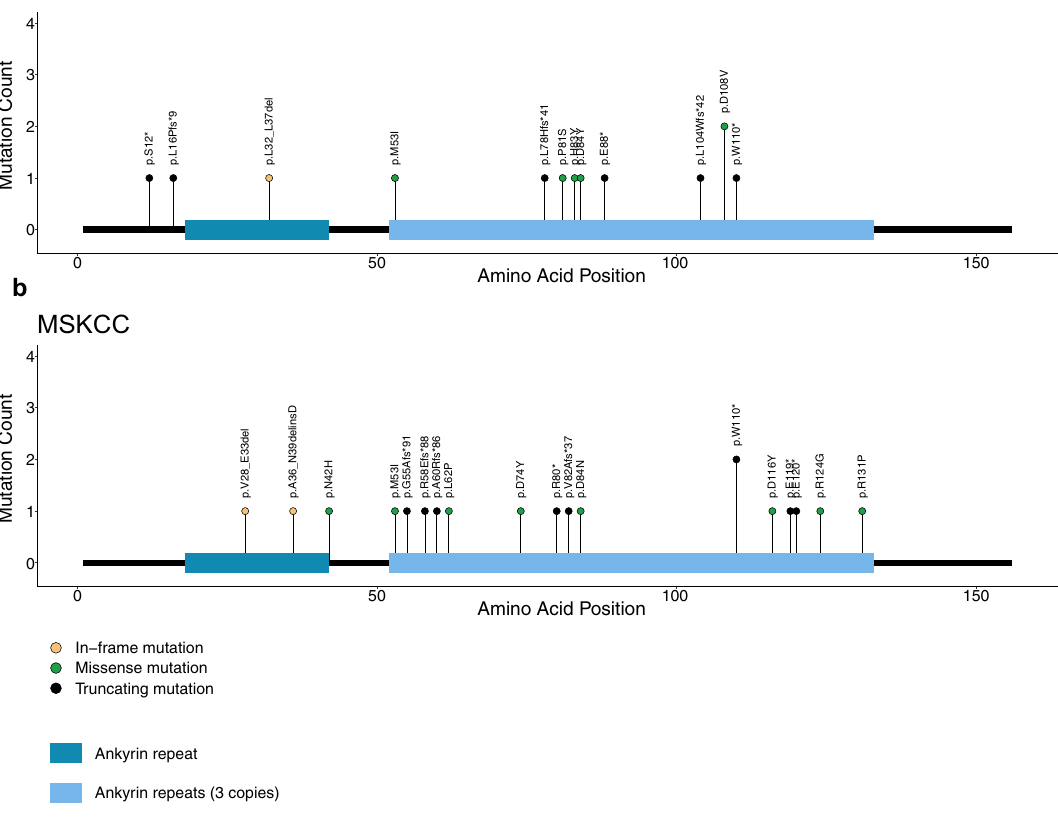
Figure 2. Genomic distribution of CDKN2A mutations. ( a ) UCMC cohort. ( b ) MSKCC cohort. Shown are amino acid changes due to mutations. Of note, loss-of-function due to gene loss are not presented in